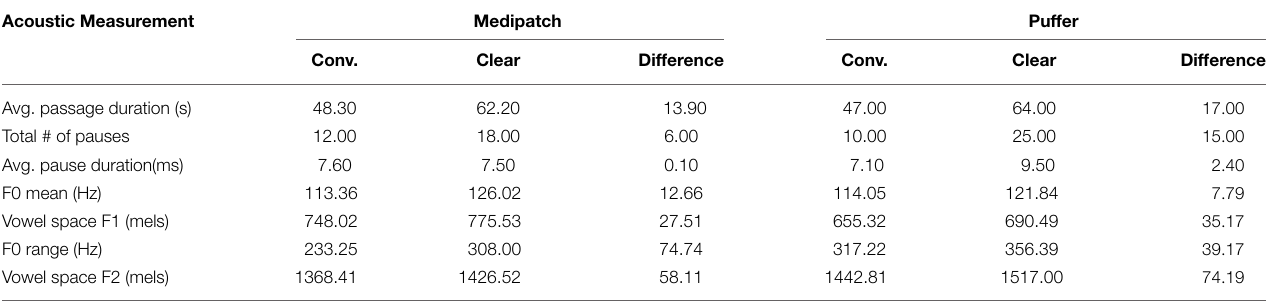
TABLE 3 | Acoustic Characteristics of Conversational (Conv.) and Clear speech.